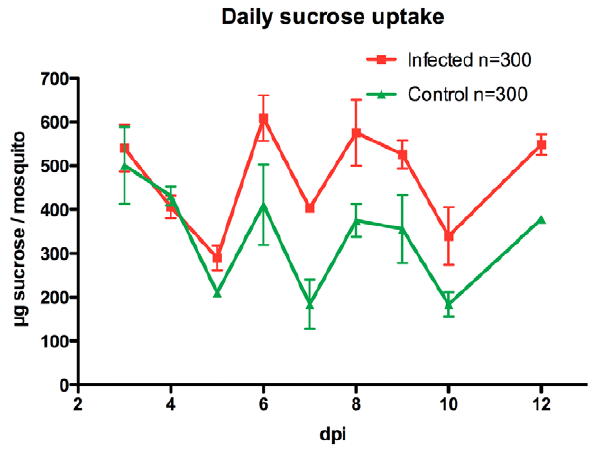
Figure 3. Sucrose uptake from P.berghei -infected and control A. stephensi mosquitoes after blood meal. Error bars indicate standard deviation from 3 biological replicates from total 300 mosquitoes per